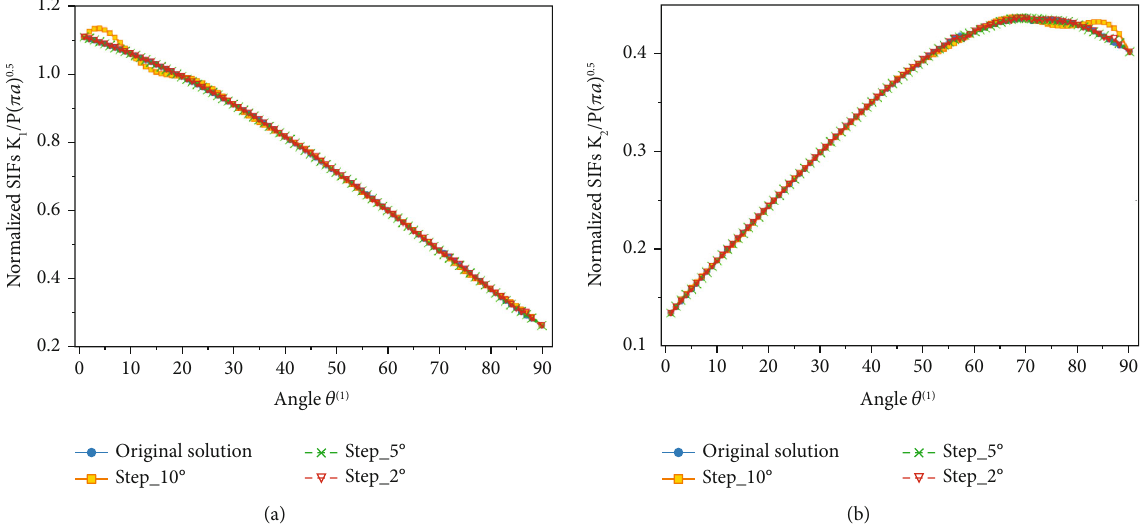
Figure 9: Di ff erent length interpolation results: (a) normalized SIFs K under di ff erent angles θ ð 1 Þ